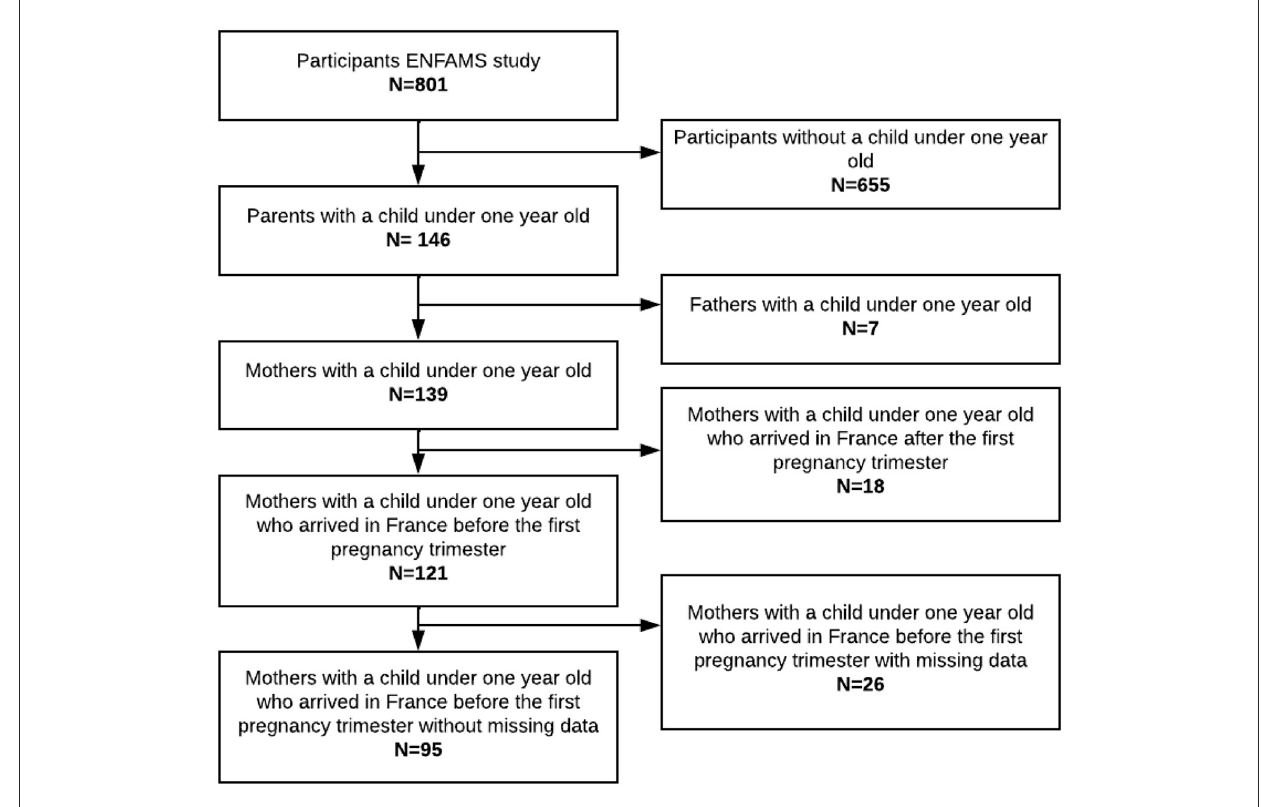
FIGURE2 Flowchart of PCU ENFAMS cross-sectional study, Greater Paris area,